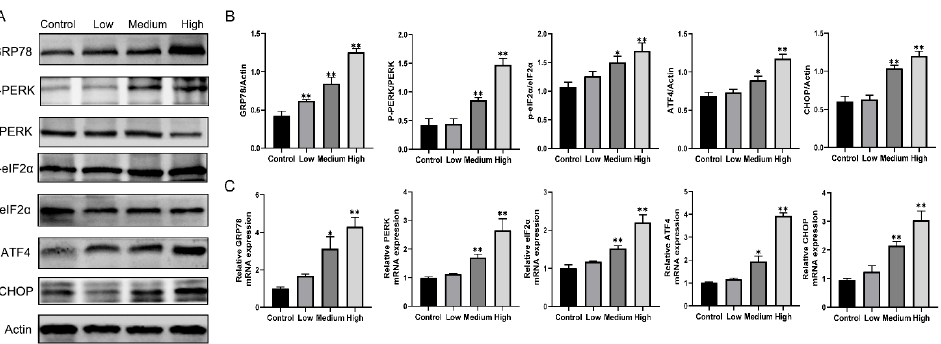
Figure 6. Gestational exposure to cyfluthrin actives ER stress-mediated PERK signaling pathway. Pregnant rats were administered corn oil or different doses of cyfluthrin (6.25, 12.5, or 25 mg/kg) daily in pregnancy. Rat placentas were collected on GD19. ( A ) Western blot image of GRP78, PERK, eIF2 α , ATF4, and CHOP expression. ( B ) Expression levels of GRP78, PERK, eIF2 α , ATF4, and CHOP protein. ( C ) Expression levels of GRP78, PERK, eIF2 α , ATF4, and CHOP mRNA. Values are expressed as the mean ± SE. The result was analyzed with one-way ANOVA followed by Dunnet’s t-test. * P < 0.05, ** P < 0.01 compared to controls.